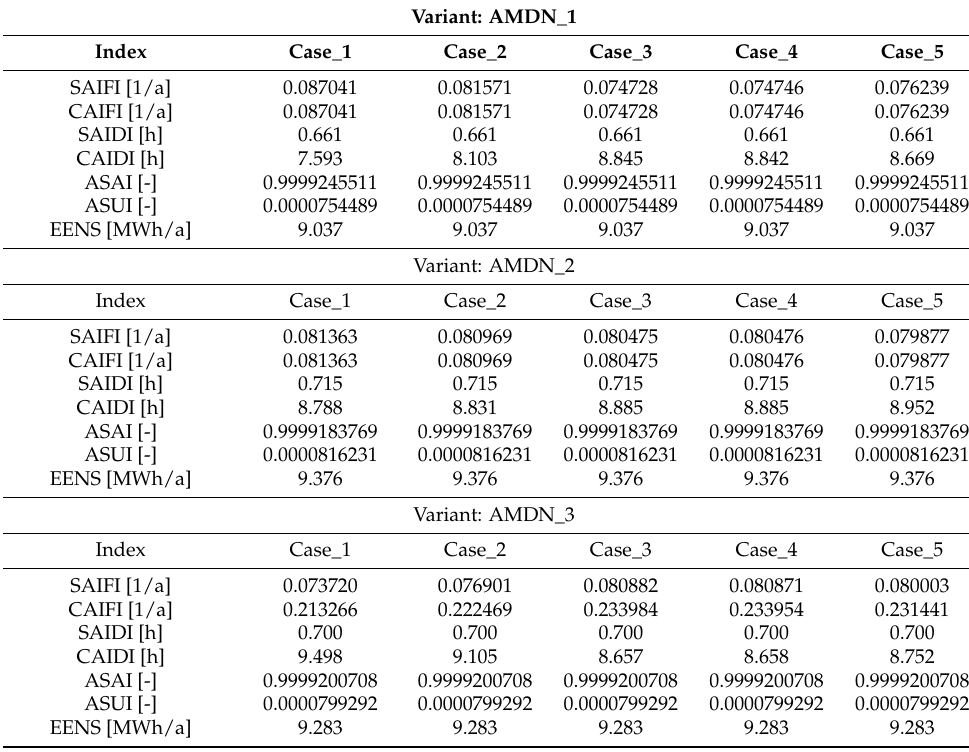
Table 12. Reliability system indices for AMDN structure (Figure